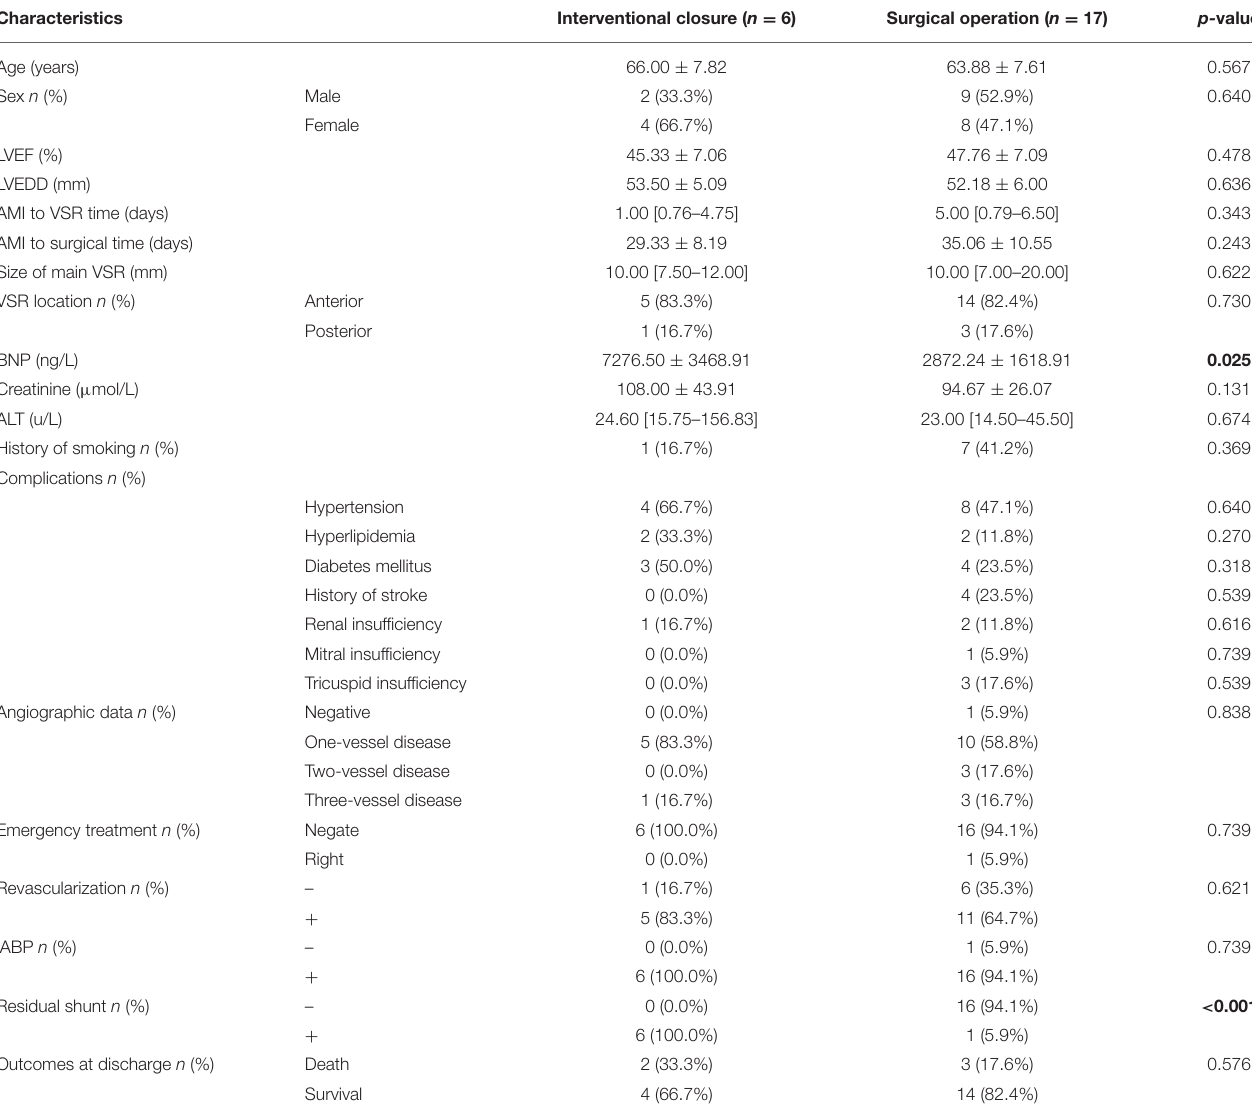
TABLE 1 | Baseline characteristics of patients with different treatment